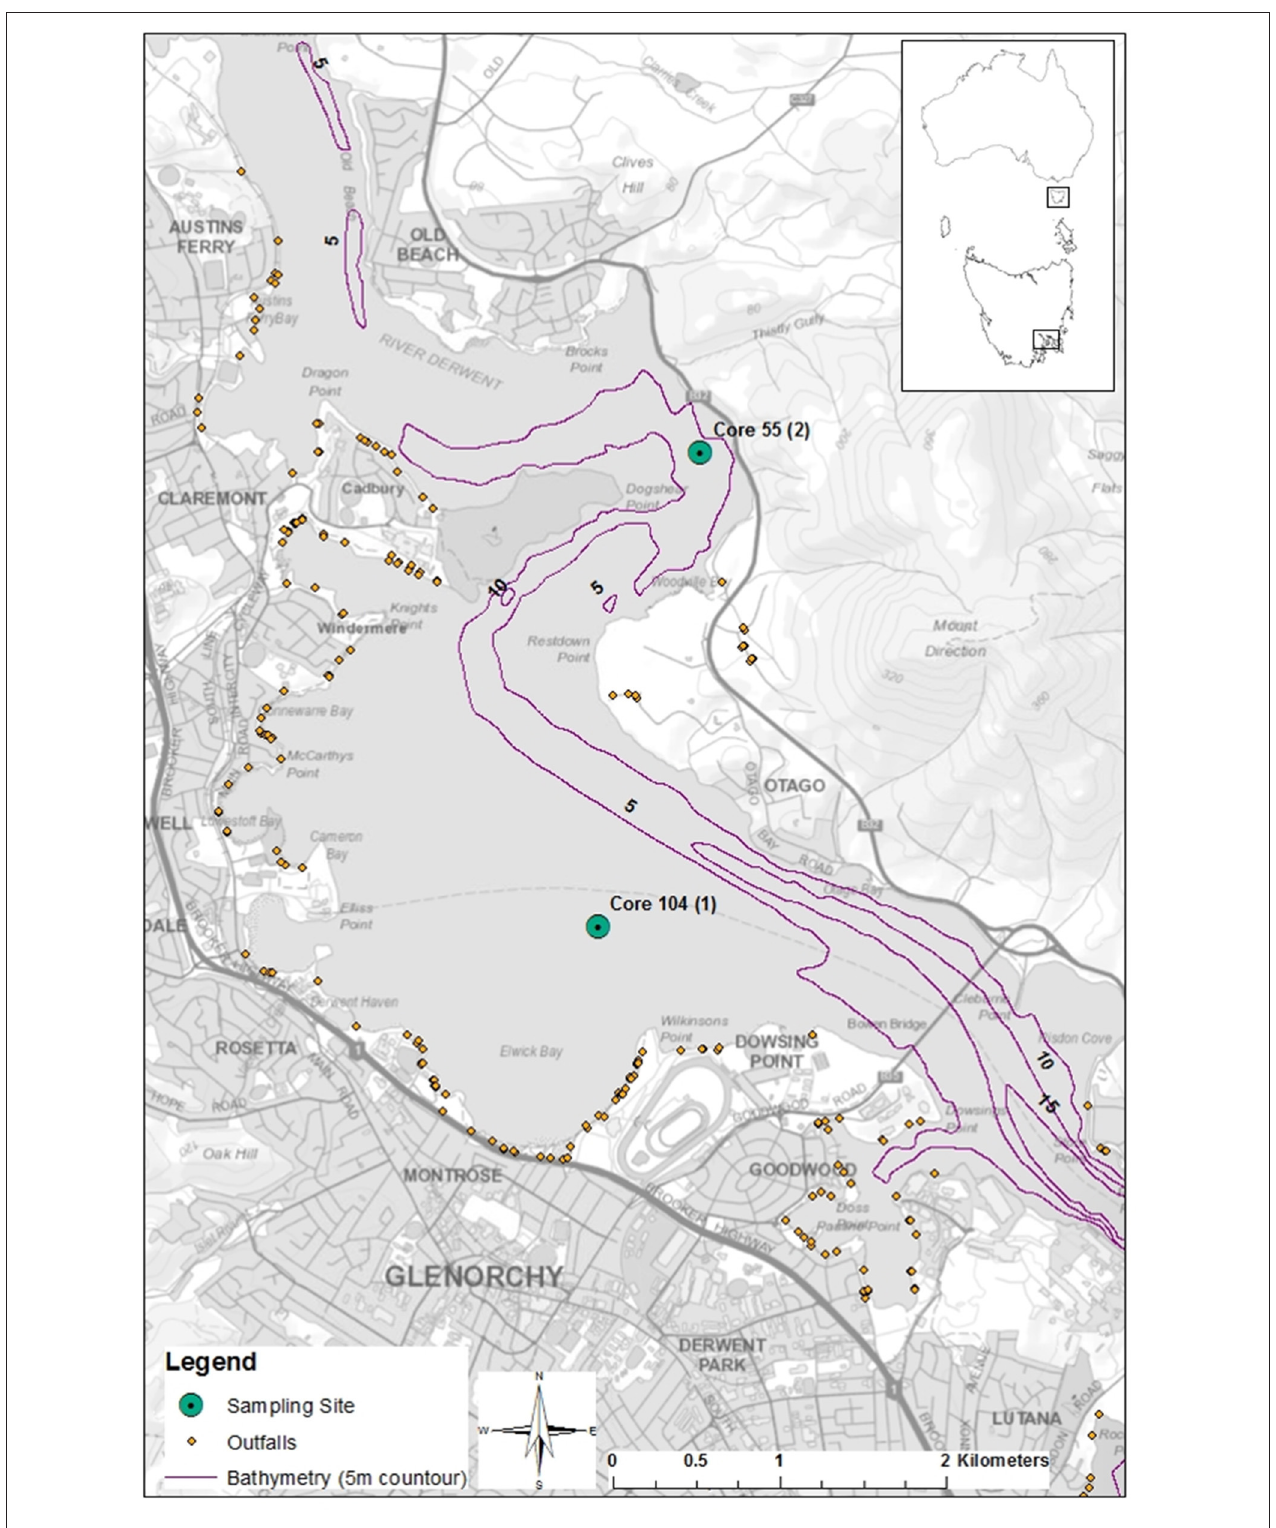
FIGURE 1 | Core sample locations in the Derwent Estuary, Tasmania, Australia. River flows north to south. Generated by Kathryn Willis using ArcGIS, [Desktop version 10.2], (https://www.arcgis.com/features/index.html). Bathymetry from Lucieer (2007), SeaMap Tasmania Bathymetric Data. Tasmanian Aquaculture and Fisheries Institute. Data accessed at http://metadata.imas.utas.edu.au/geonetwork/srv/eng/metadata.show?uuid=fa2dbc70-44ab-11dc-8cd0-00188b4c0af8 on 27/04/2017.